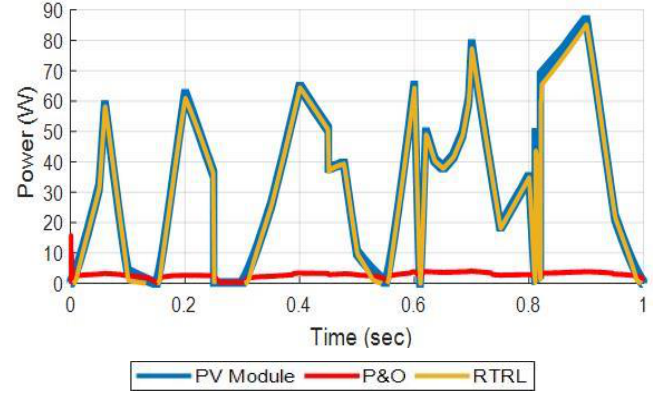
Figure 17. Results obtained with the P&O and RTRL controllers for variable signals of irradiance and temperature.